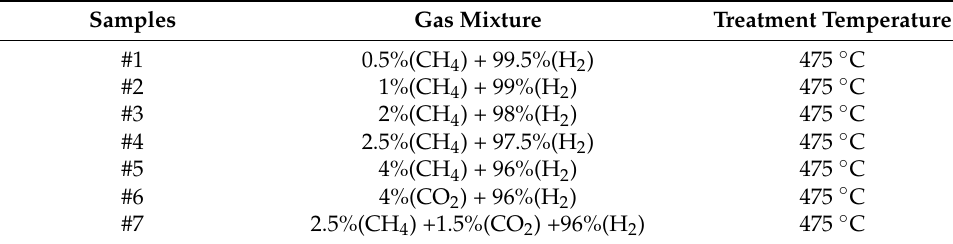
Figure 3. TTT diagram of austenitic stainless steels. Table 1. Gas mixture and temperature used for treating different groups of